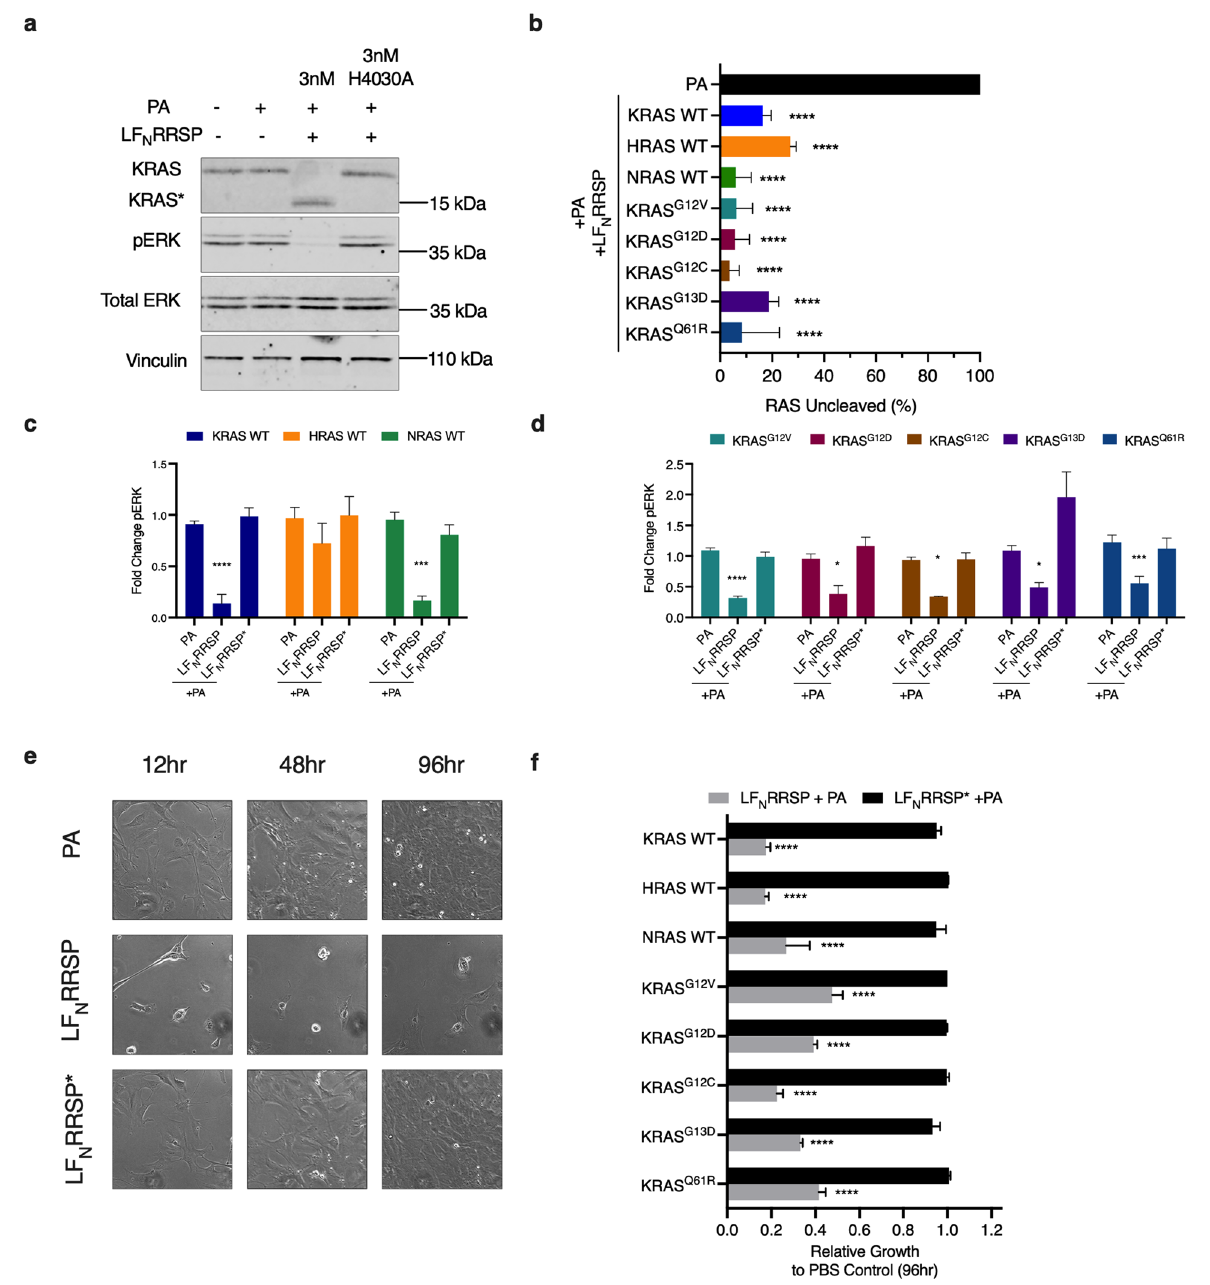
Figure 1. LF N RRSP cleaves and inhibits all RAS isoforms and KRAS oncogenic mutants in RAS-less MEFs. ( A ) Representative western blot analysis of LF N RRSP cleavage of RAS and inhibition of ERK in KRAS WT RAS- less MEFs after 24 h. Vinculin was used as a gel loading control. Protein detection for each immunoblot was analyzed on the same blot. Protein detection for each immunoblot was conducted on the same blot and cropped for each individual protein of interest. Full length blots can be found in Supplementary Fig. 7. ( B ) Densitometric analysis of total percent RAS in indicated RAS-less MEFs following LF N RRSP treatment for 24 h, n = 3. ( C,D ) Densitometric analysis of fold change in pERK compared to PBS control after 24 h for RAS-less MEF cell lines indicated; n = 3. ( E ) Brightfield images of KRAS WT RAS-less MEFs treated with either PA alone or in combination with LF N RRSP or LF N RRSP* at indicated timepoints. ( F ) Cell growth over time was monitored with time lapse video microscopy and quantified using Nikon Elements. Values shows relative growth inhibition in RAS-less MEFs compared to PA control at 96 h following treatment with either LF N RRSP or LF N RRSP*. Results for all panels are expressed as mean ± SEM of three independent experiments (* P < 0.05, ** P < 0.01, **** P < 0.0001 versus PA control as determined through one-way ANOVA followed by Dunnett’s multiple comparison